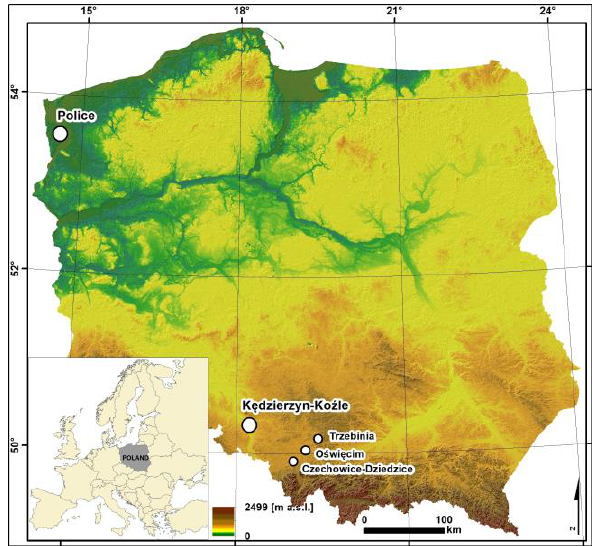
Fig. 1. Location of synthetic fuel plants and oil refineries bombed by the Western Allies during World War II (figure